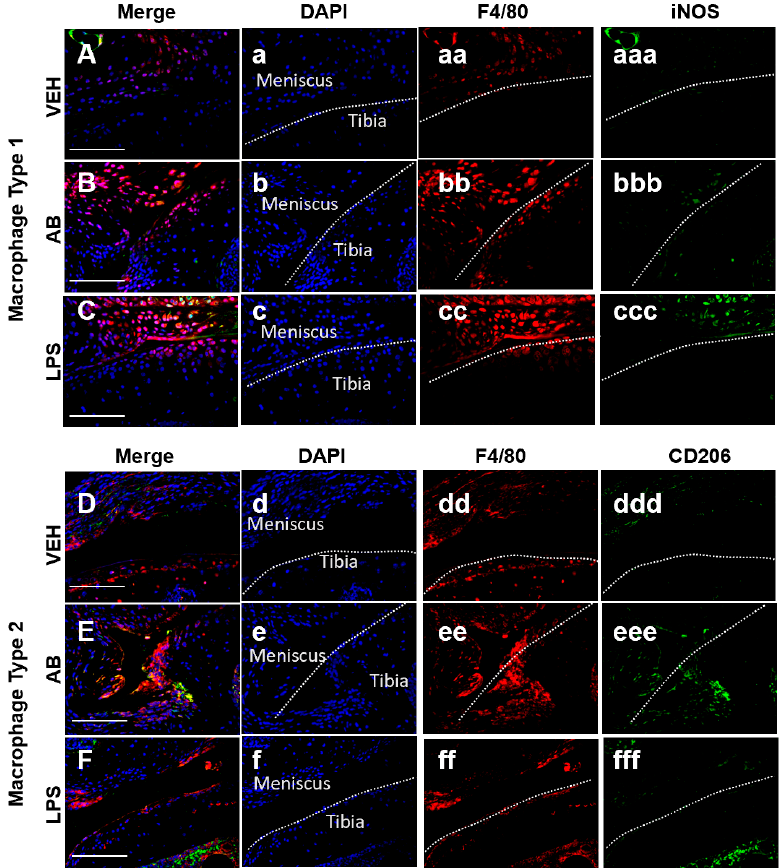
Figure 4. Macrophage infiltration analysis of the VEH-, AB-, and LPS-treated injured joints. ( A – C ) Fluorescent immunohistochemistry (IHC) of macrophage type 1 markers F4 / 80 and iNOS. ( D – F ) Fluorescent IHC of macrophage type 2 markers F4 / 80 and CD205. Dashed line in white represents the surface of the anterior tibial condyle for all images. ( a – f ) DAPI; ( aa – ff ) F4 / 80; ( aaa – ccc ) iNOS; ( ddd – ff f ) CD206. White scale bar represents 100 µ